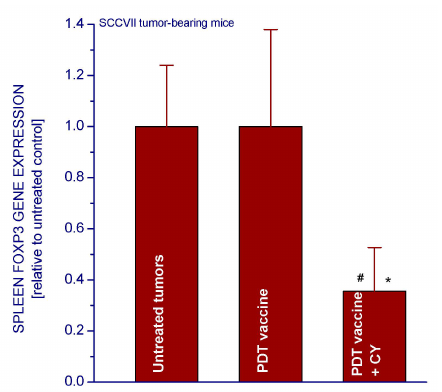
Figure 5. The effect of cyclophosphamide treatment on the expression of Foxp3 gene in the spleens of SCCVII tumor-bearing mice that received PDT vaccine. The mice were sacrificed three days after vaccination (as in Figure 1) followed by cyclophosphamide injection (50 mg/kg i.p.) two days later. Their spleens were collected for Foxp3 gene expression analysis based on quantitative RT-PCR. The results, GAPDH-normalized mouse Foxp3 gene expression, are presented relative to corresponding values in spleens of untreated controls. Treatment groups consisted of four mice. # Statistically significant difference from untreated tumors group ( p < 0.05); * statistically significant difference from vaccine alone group ( p < 0.05).